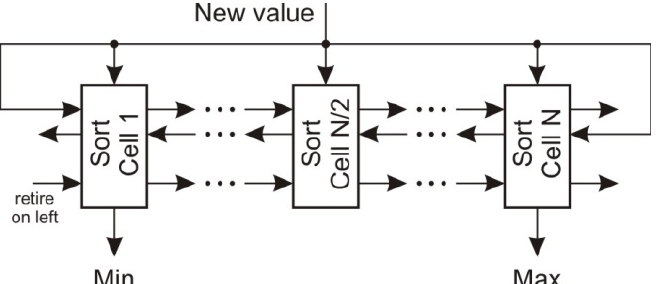
Figure 5. Insertion sort